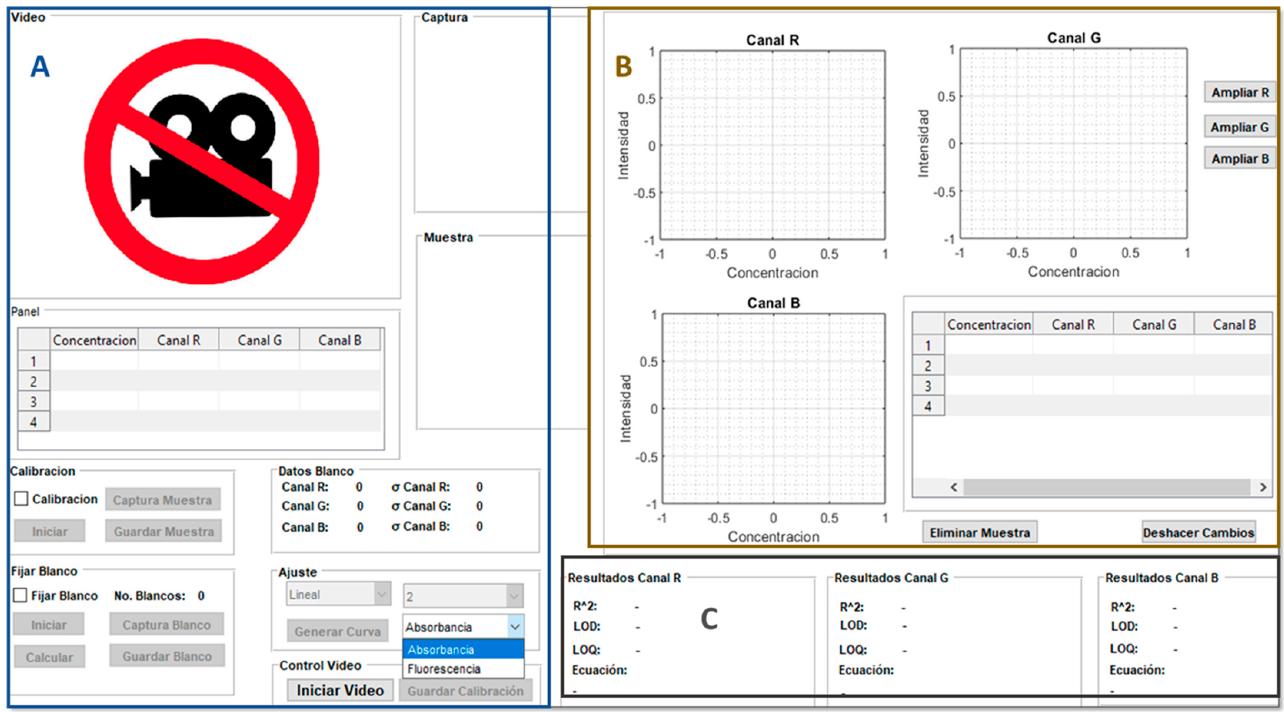
Figure 5. Digital image processing by program Matlab developed.